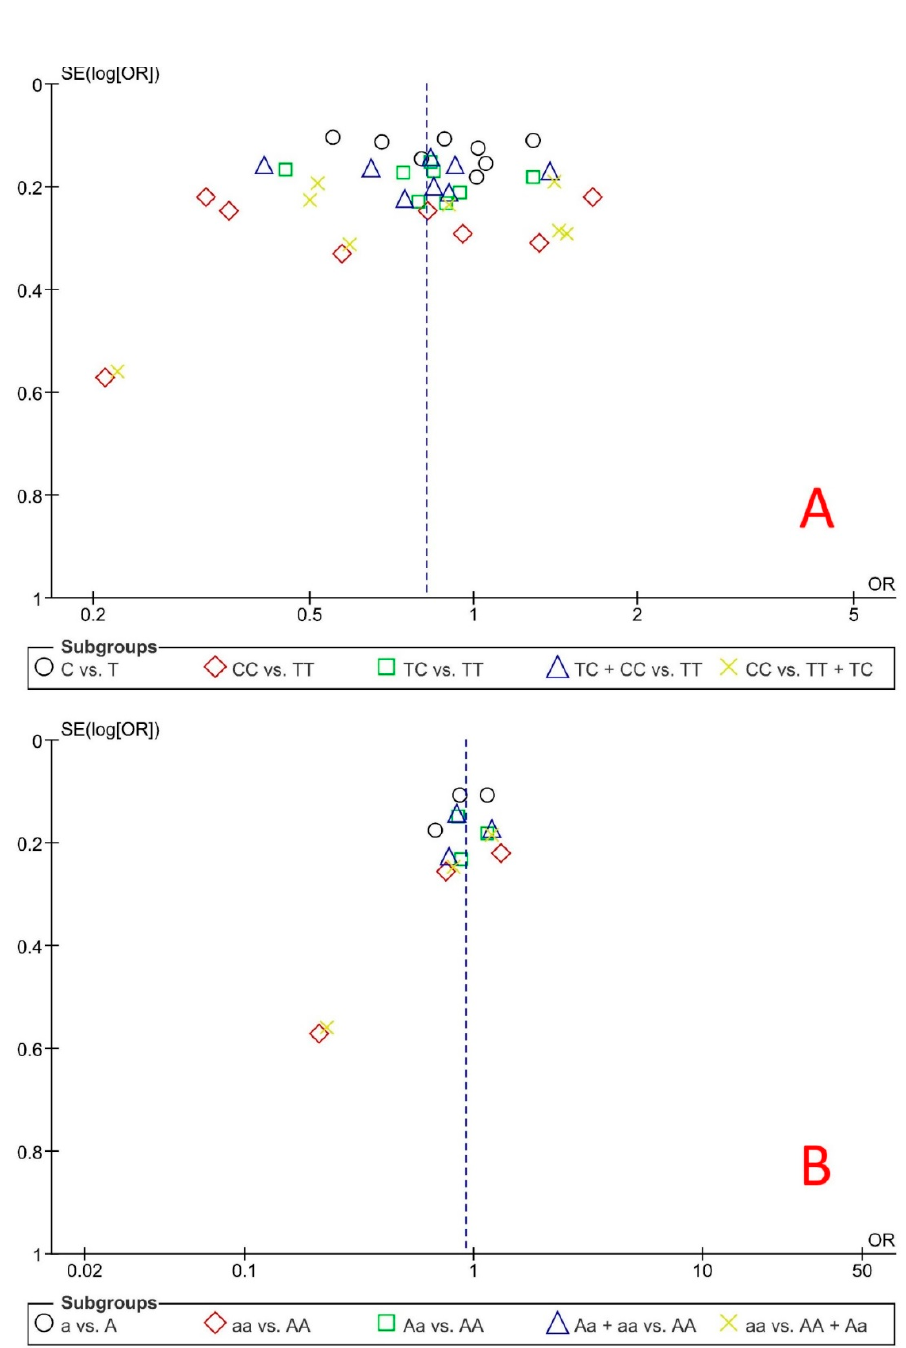
Figure 4. Funnel plot of the risk of non ‐ syndromic cleft lip/palate related to ( A ) rs13041247 and ( B ) rs11696257 MAFB polymorphisms based on five genetic models (SE: standard errors vs. OR: Odds ratio).